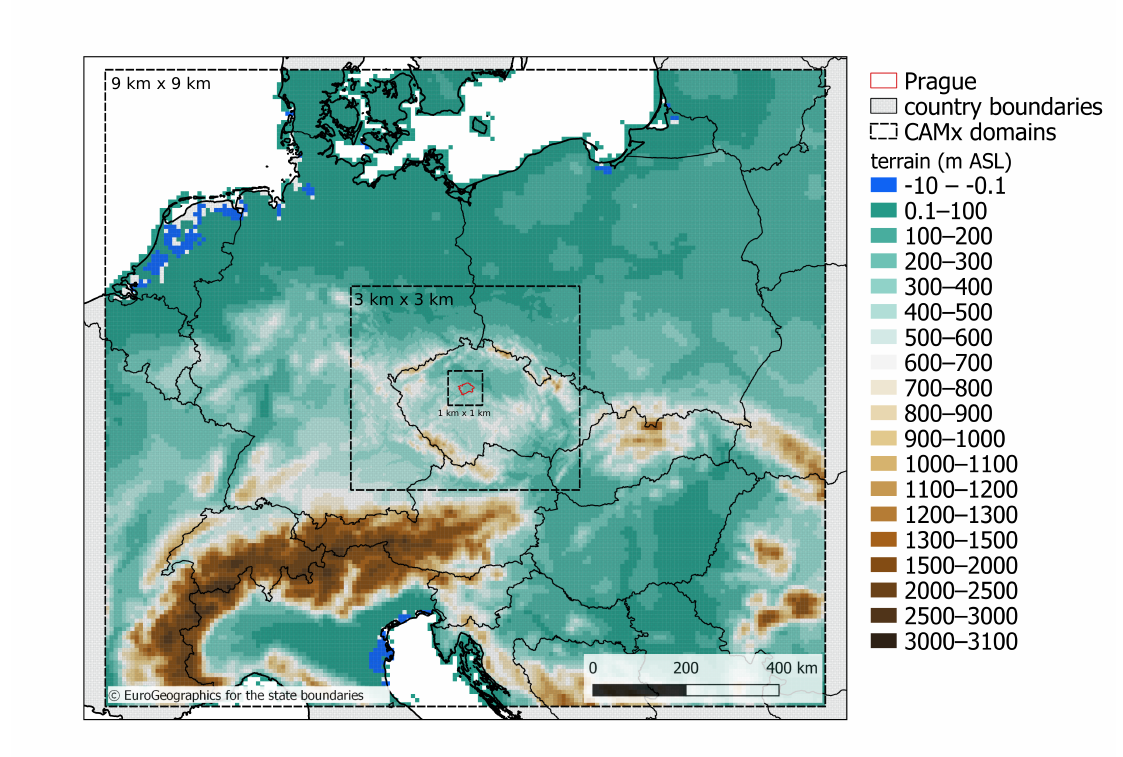
Figure 2. The simulation domains of WRF and the Comprehensive Air Quality Model with Extensions (CAMx).